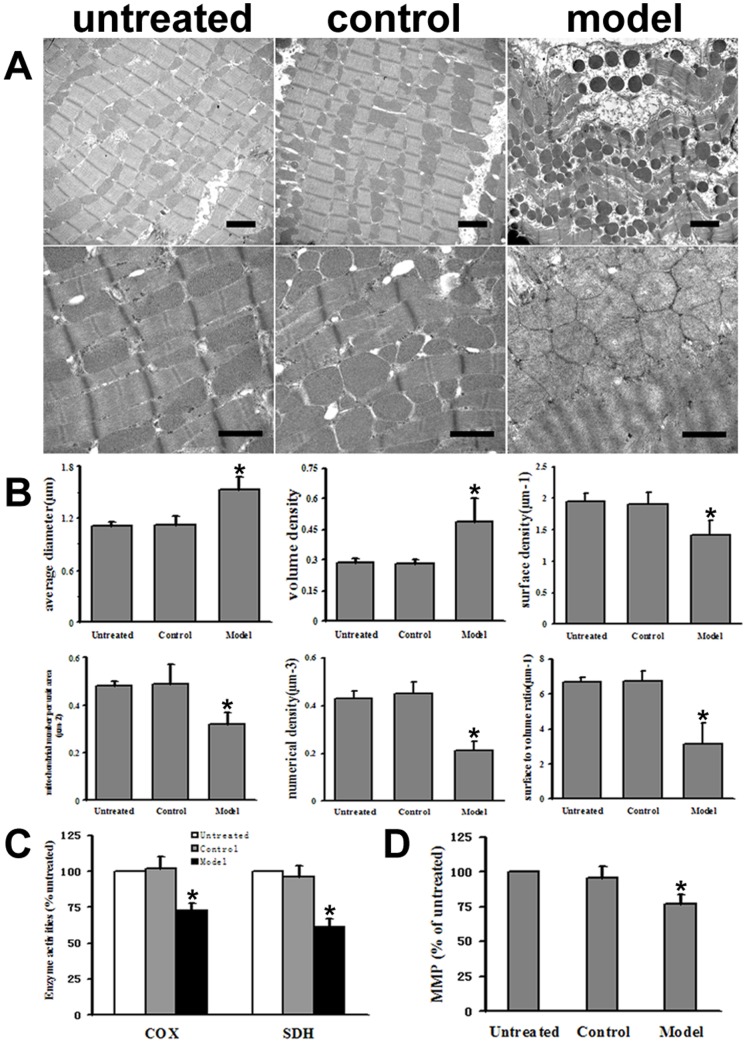
Mitochondria structure and function in the rat hearts.A: Ultrastructure of the rat cardiomyocytes. Normal histological structure of the myocardium was shown in the untreated and control groups. Model group displayed prominent myofilament disarray and rupture, cytoplasmic vacuolization, significant mitochondrial swelling, and focal dissolution of mitochondrial cristae. The upper scale bar = 2 µm, and the lower scale bar = 1 µm. B: Stereological parameters of myocardial mitochondria among the three experimental groups. Data are mean ± SD (n = 6, 6 and 10 respectively). Stereological analysis of cardiac mitochondria from the model group showed notable increases in average diameter and volume density, and remarkable decreases in surface density, mitochondrial number per unit area, numerical density and surface to volume ratio compared with the control values. C: Compared with the control group, COX (Cytochrome c oxidase) and SDH (succinate dehydrogenase) activities of cardiac mitochondria in the model group were significantly decreased. Data are mean ± SD (n = 6, 9 and 16 respectively) D: MMP (mitochondrial membrane potential) level of the freshly isolated cardiac mitochondria in the model group significantly decreased. Data are mean ± SD (n = 6, 9 and 16 respectively). *P<0.05 versus the control group.